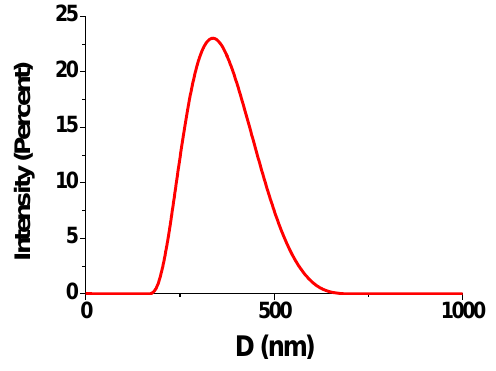
Figure 4. DLS particle size distribution by intensity in retentate in a Blank B experiment for K = 1. Indeed, the individual Ca n PAA-F1 aggregates are then detected on the membrane surface as bright green spheres with a size ranging from 10 to 20 μm, Figure 5. Crystals 2020 , 10 , x FOR PEER REVIEW